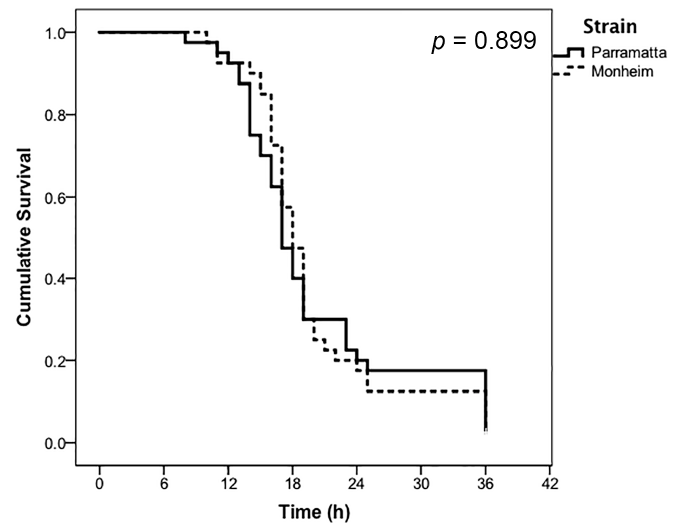
Figure 1. Proportional cumulative survival in response to continuous exposure to the prescribed label rate of CimeXa Insecticide Dust of Parramatta (resistant) and Monheim (susceptible) strains of Cimex lectularius ( n = 40 bugs per strain, control mortality = 0%).